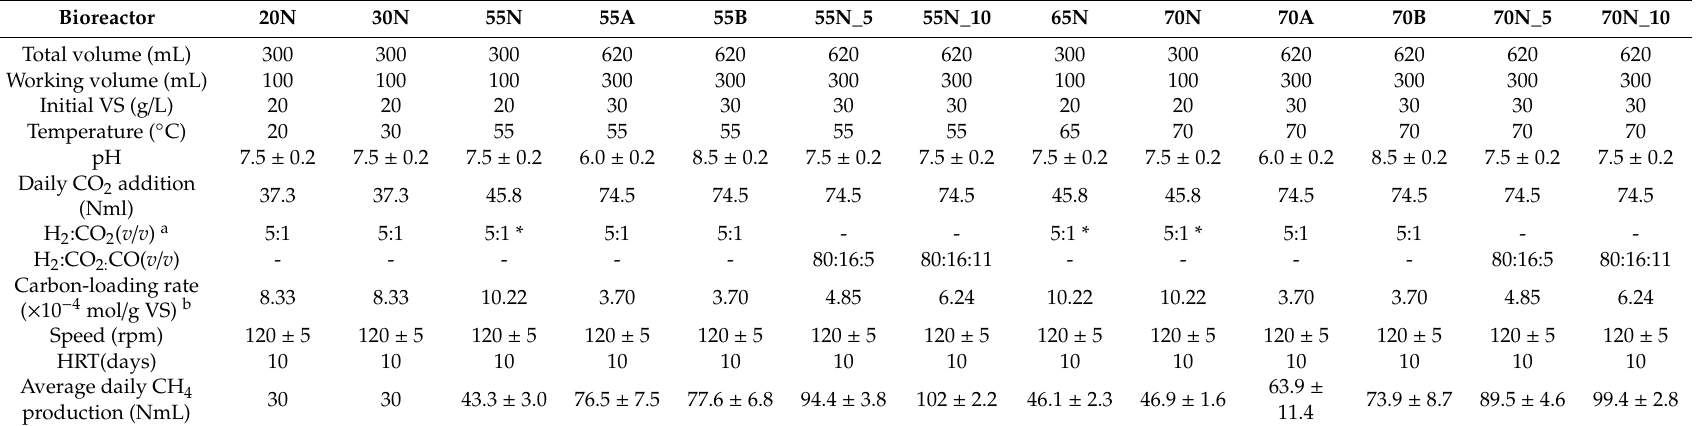
Table 1. Information regarding the operational parameters and CH 4 production performance of each acclimation